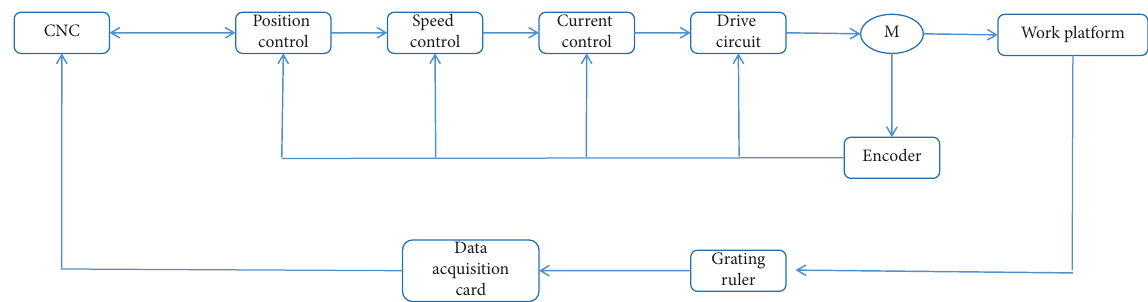
Figure 7: Arc and straight-line transition coordinate